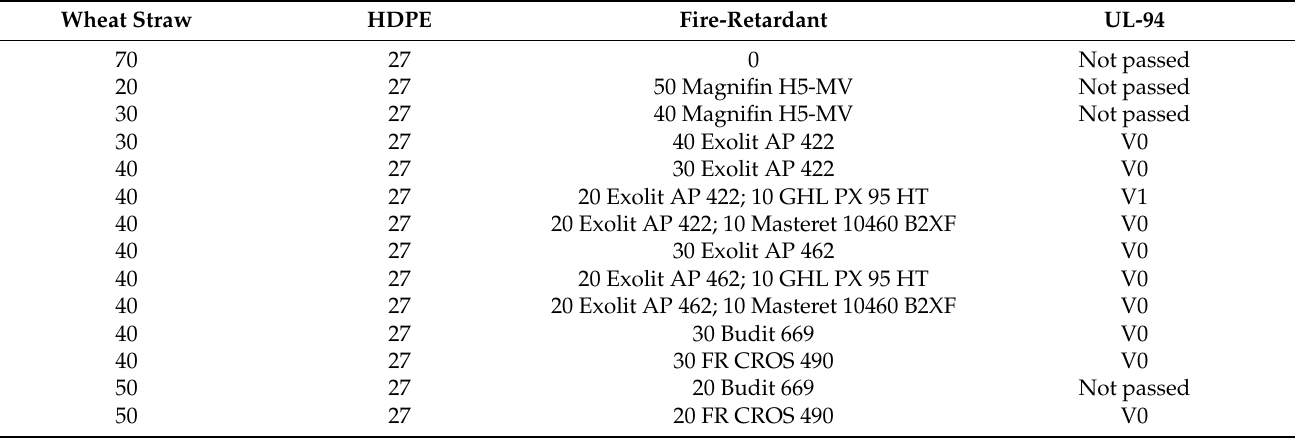
Table 1. Results of UL-94 tests with materials for co-extruded layer. Thickness of pressed sheets was 0.8 mm. Amounts represent wt.%. In each formulation, 3% of coupling agent (MAPE) was included. Wheat Straw HDPE